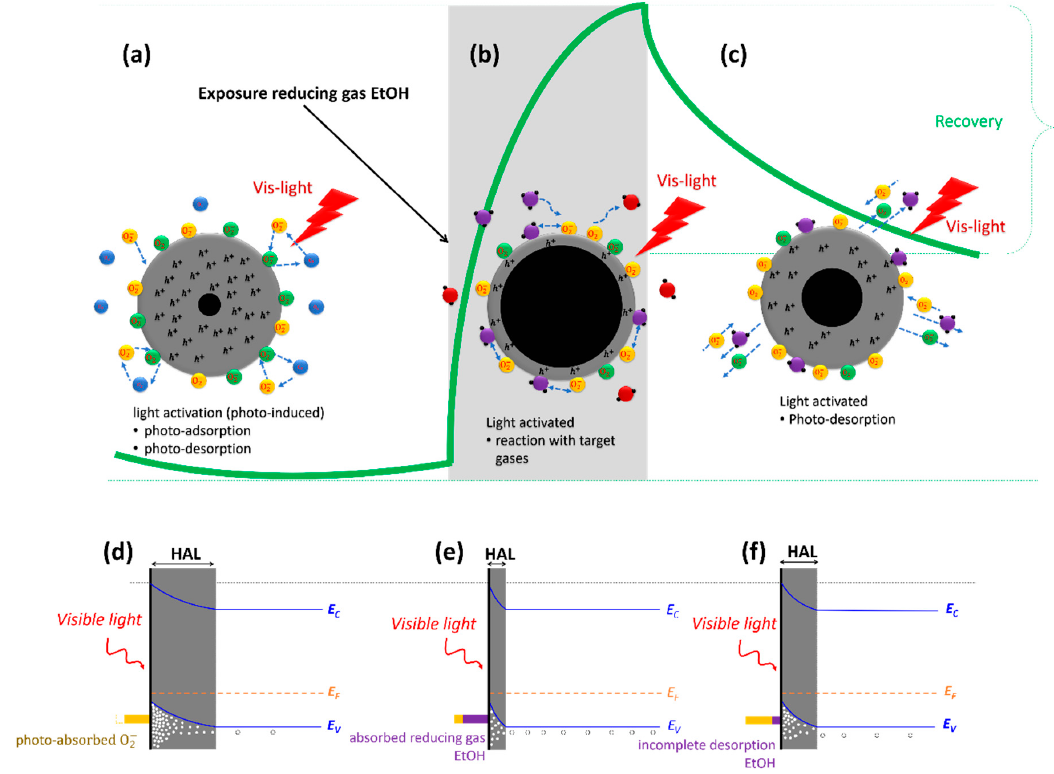
Figure 6. The dynamic response (the green line) toward reducing gas (i.e., ethanol vapors) under visible light irradiation that corresponded to: ( a ) photo-activation before target gas exposure has been introduced, ( b ) target gas interacts with photo-induced oxygen ion and attaches on the surface (photo-adsorption process), ( c ) photo-desorption process when target gas is detached from the surface, ( d ) energy band diagram photo-activation before interaction with target gas, ( e ) photo-adsorption process causes a decreasing the width of HAL and increasing of the electrical resistance, and ( f ) photo-desorption process causes an increasing the width of HAL and resulting in a decrease the electrical resistance of CaFe 2 O 4 .